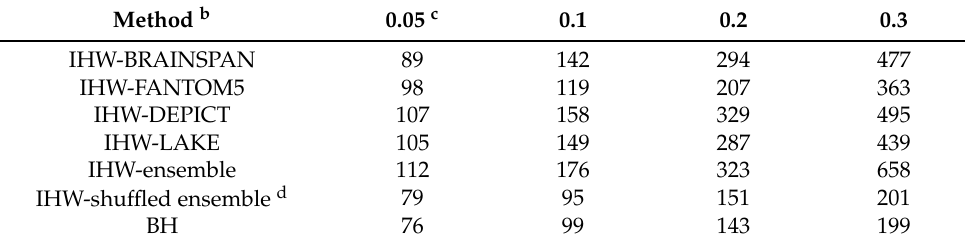
Figure 6. Histograms of ASD p -values after splitting the hypotheses into three groups by the predic- tion score. A successive increase of the number of hypotheses with p -values near zero is observed for increasing scores, indicating that the proportion of non-null effects varies across different groups. Table 3. Number of discoveries from ASD dataset, by different methods and covariates a . Method